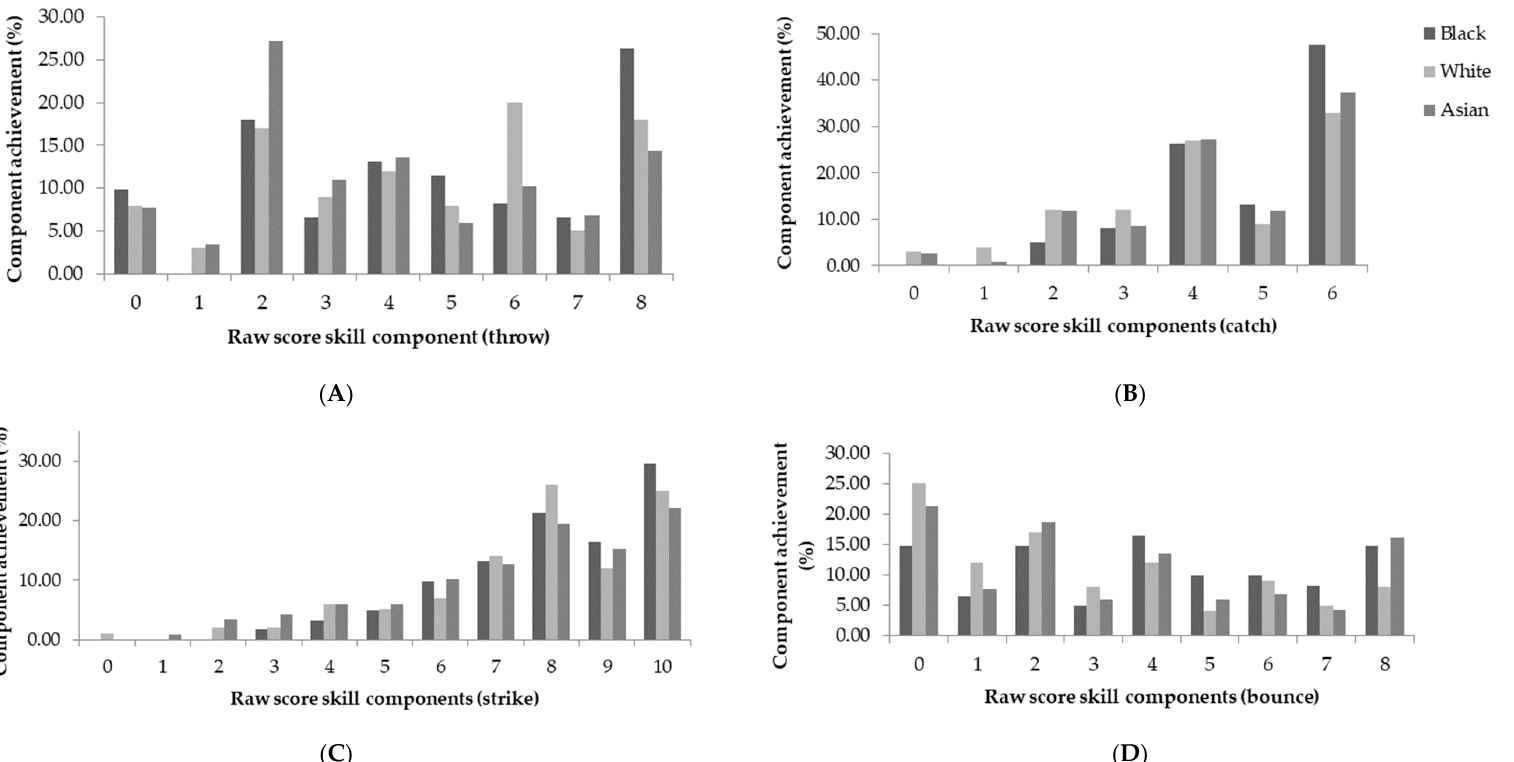
Figure 5. Component achievement (%) of object control skills by ethnicity; ( A ) Throw; ( B ) Catch; ( C ) Strike; and ( D ) Bounce.